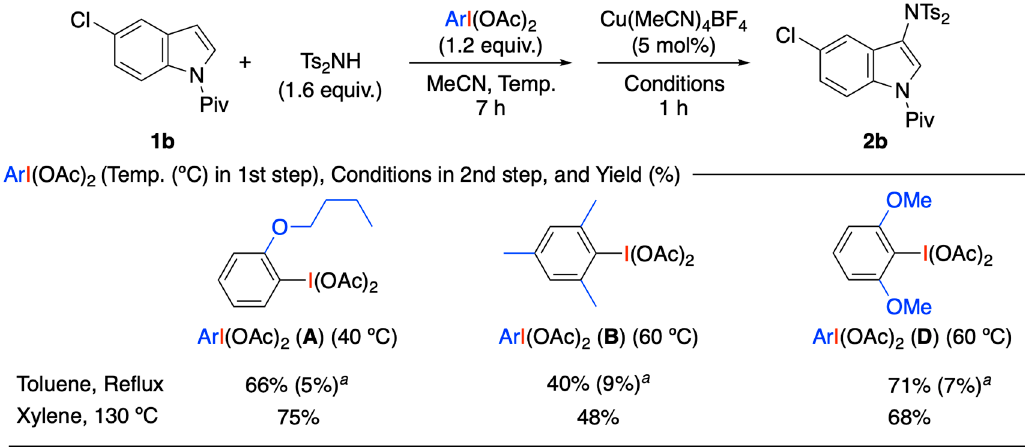
Table 1. Screening for ArI(OAc) 2 and solvent for 3-amination of indole ( 1a ).